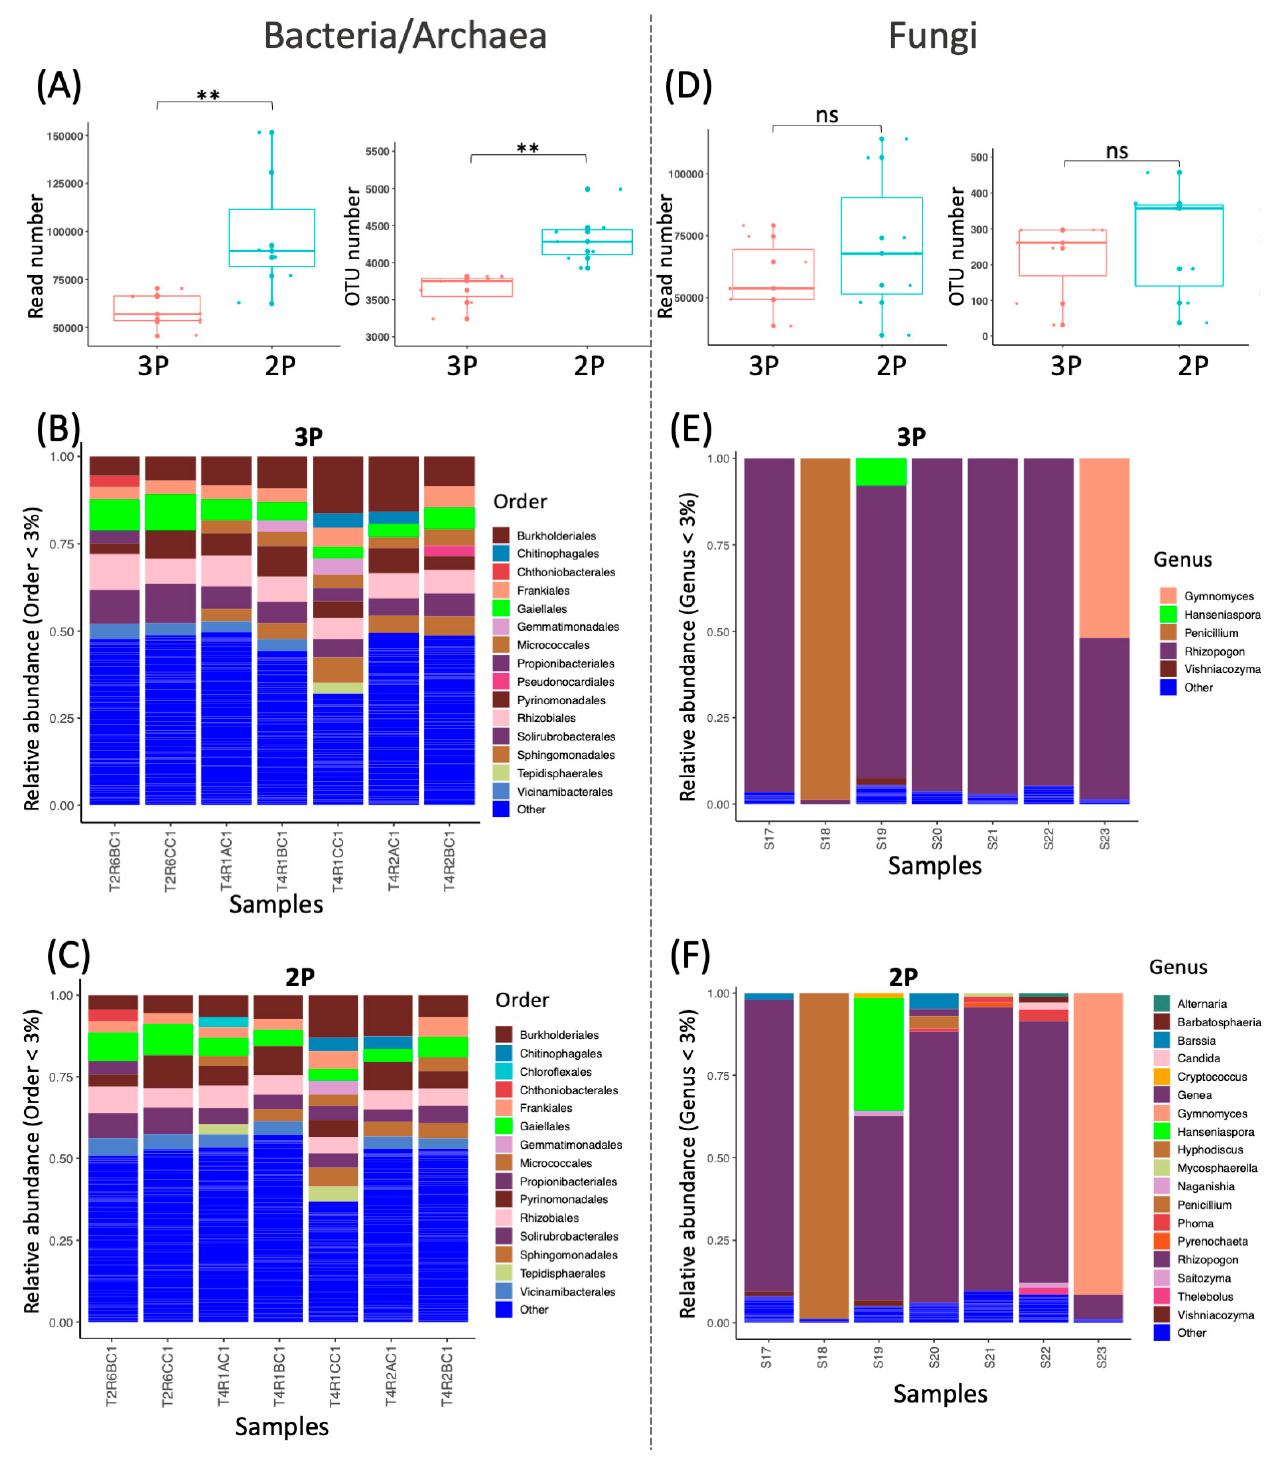
Figure 6. Comparison of sequence results obtained for bacteria and fungi (dataset 4, Supplementary Method S1, Table S6) using the three-step (3P) and two-step (2P) protocols. All library preparation and sequencing were conducted at the RTSF Genomics Core at Michigan State University. ( A – C ) Sequence results of bacteria. ( A ) Read number and alpha diversity (observed number of species) detected with the 2P and 3P protocols ( B , C ) Order level taxonomic composition of the 3P- and 2P-prepared libraries. ( D – F ) Sequence results of fungi. ( D ) Read number and alpha diversity (observed number of species) detected with the 2P and 3P protocols. ( E , F ) Genus level taxonomic composition of the 3P- and 2P-prepared libraries. Welch two-sample t -test was conducted. ** p value < 0.01, ns = not significant.